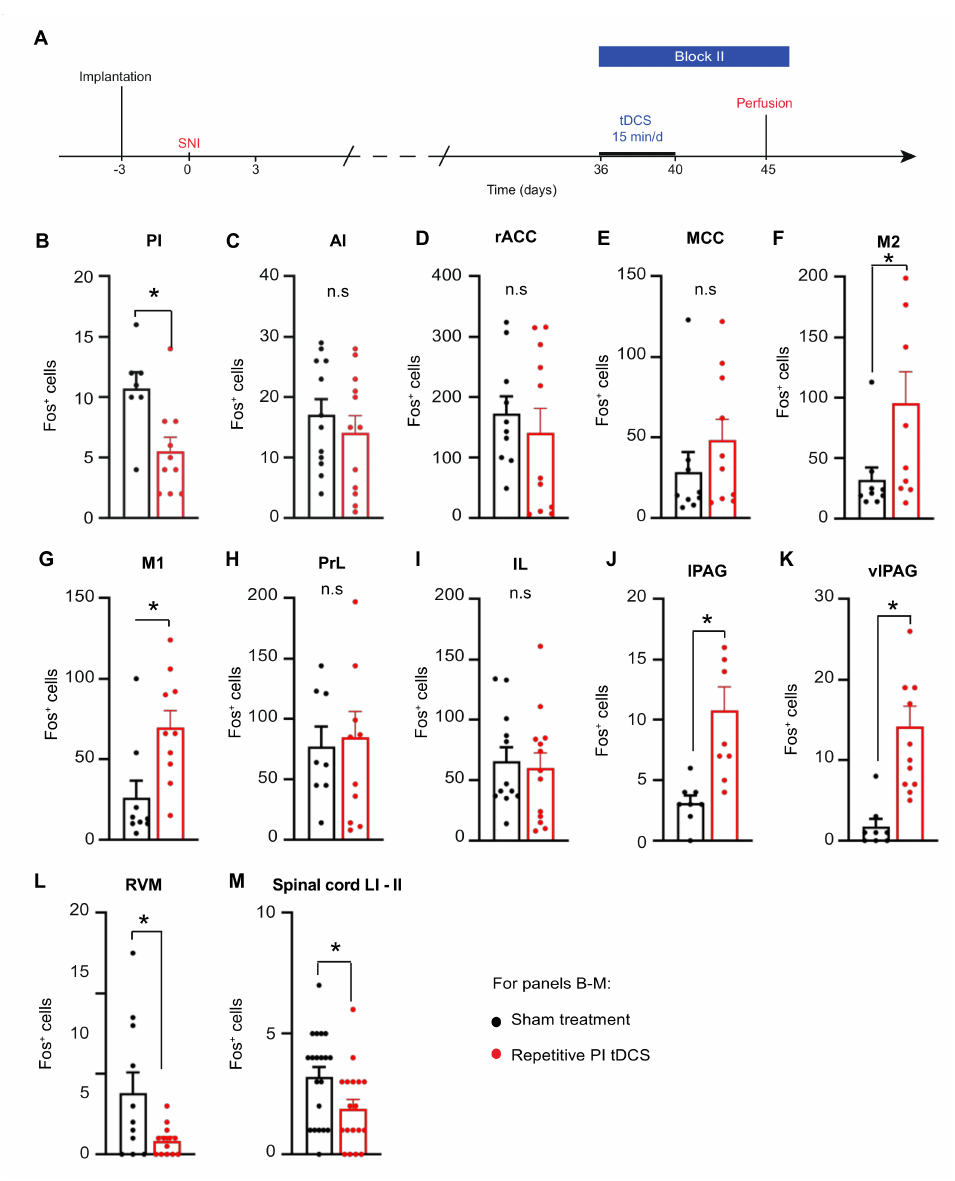
Figure 7. Immunohistochemical analysis of Fos in diverse brain regions following repetitive tDCS or sham stimulation of the PI in mice with neuropathic pain. Shown are the experimental scheme of tDCS or sham stimulation after SNI ( A ) and quantitative summary of Fos-positive cells in diverse brain regions ( B – M ). n = 6–12 sections from two to four mice for each area; an unpaired t test was performed; * p < 0.05 as compared to the corresponding control group. n.s.: non-significant. Additional abbreviations: LI-LII: spinal superficial laminae I and